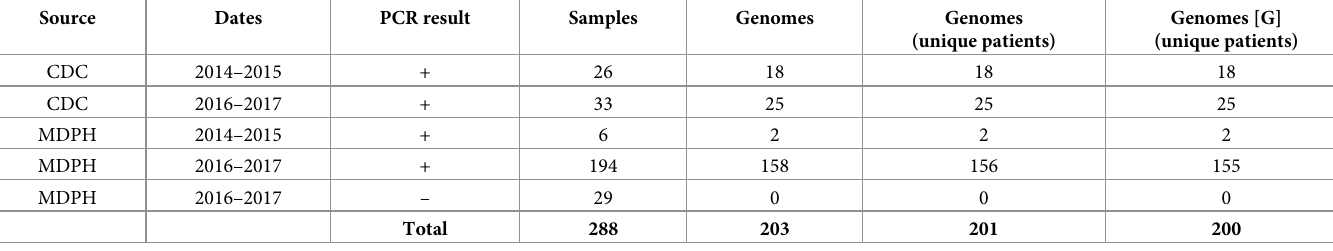
Table 1. Summary of samples and genomes. Counts of samples sequenced and genomes generated by source (MDPH or CDC), date, and mumps virus PCR result. [G] indicates genotype G genomes. Two genomes are from a second sample of a patient already included in the data